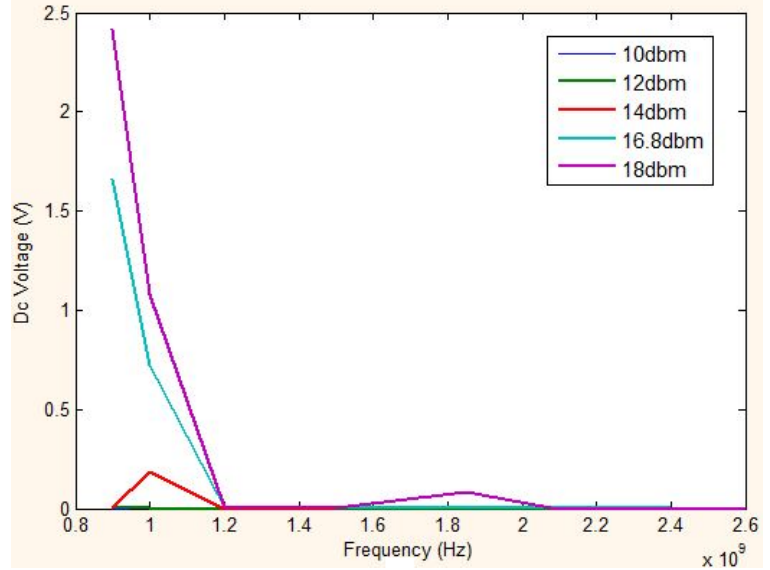
Figure 9. DC voltage at the fifth stage of the self ‐ developed RF ‐ EH board when powering the MSP ‐ EXP430G2 kit. The distance between the TX and RX antennas is 5 cm.